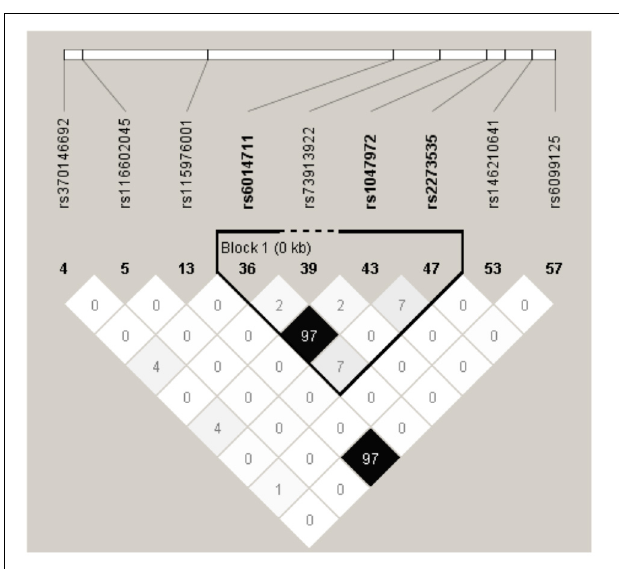
FIGURE 4 | The tagger SNPs in AURKA gene. Linkage disequilibrium (LD) blocks across the locus in Chinese Han. LD value shown: r 2 × 100; r 2 color scheme: r 2 = 0, white; 0 < r 2 < 1, shades of gray; r 2 = 1,